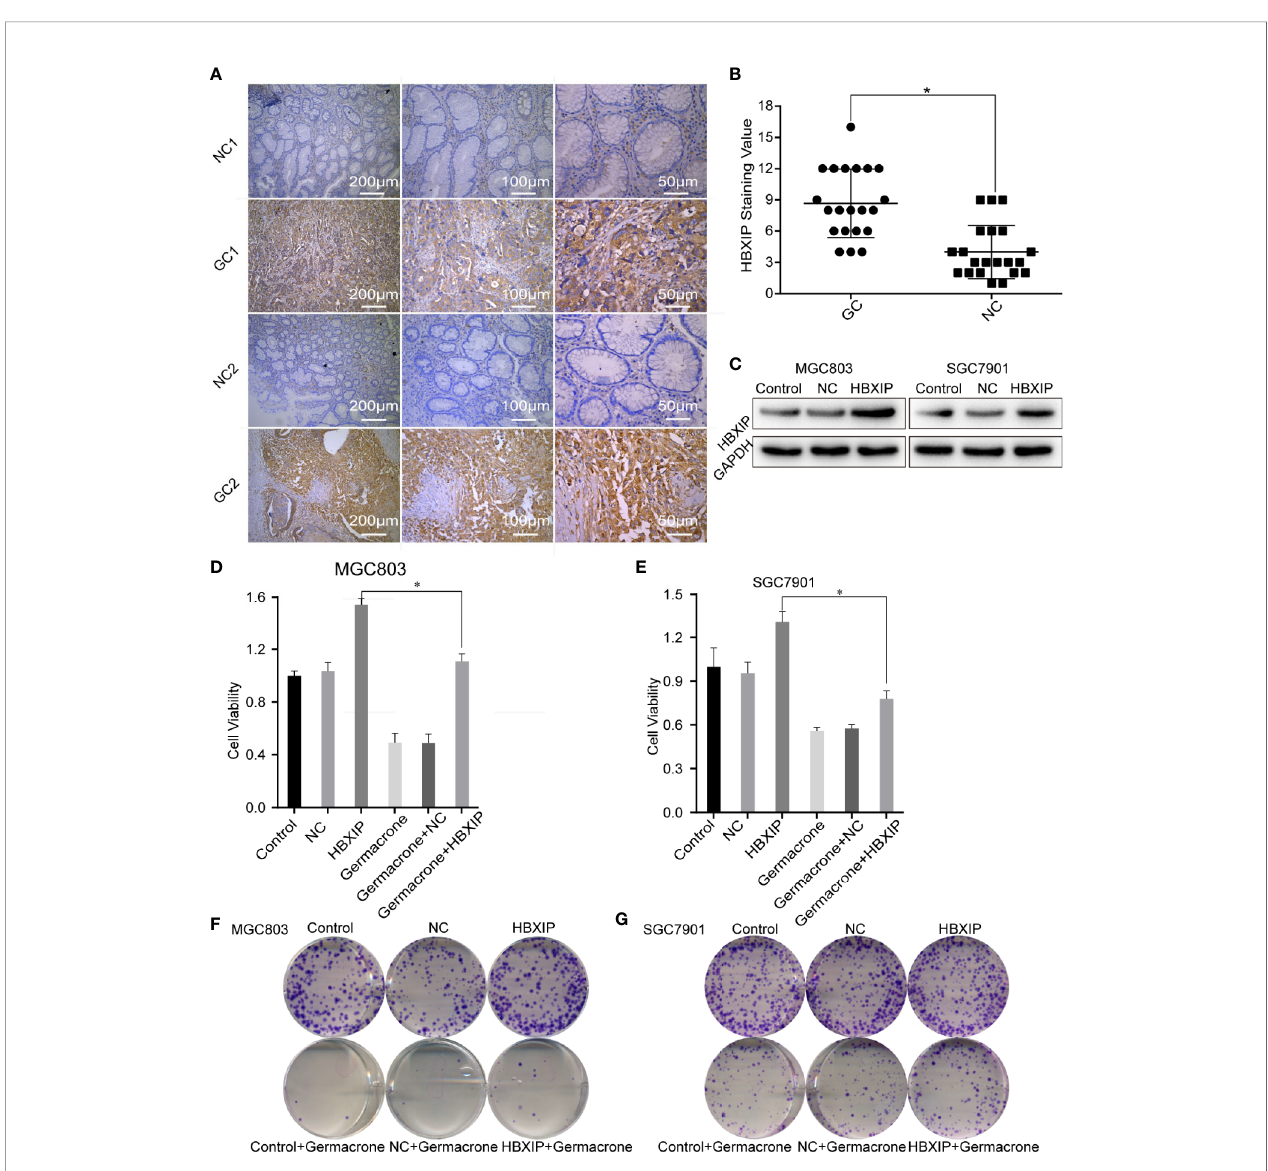
FIGURE 6 | HBXIP highly expressed in gastric cancer and involved in the germacrone regulation. (A, B) Immunohistochemistry was used to detect the expression of HBXIP in tissue from gastric cancer patients and matched adjacent tissues. (C) A HBXIP overexpression model was constructed in gastric cancer cells. (D, E) An MTT assay was used to evaluate the effects of germacrone and overexpression of HBXIP on cell viability. (F, G) A colony formation assay was used to assess the effects of germacrone and overexpression of HBXIP on cell viability. * P < 0.05.